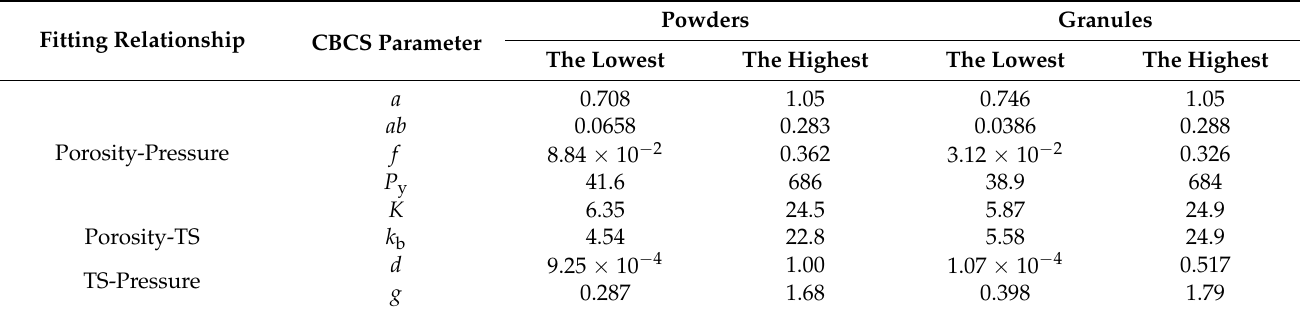
Table 2. The lowest and highest values of each CBCS